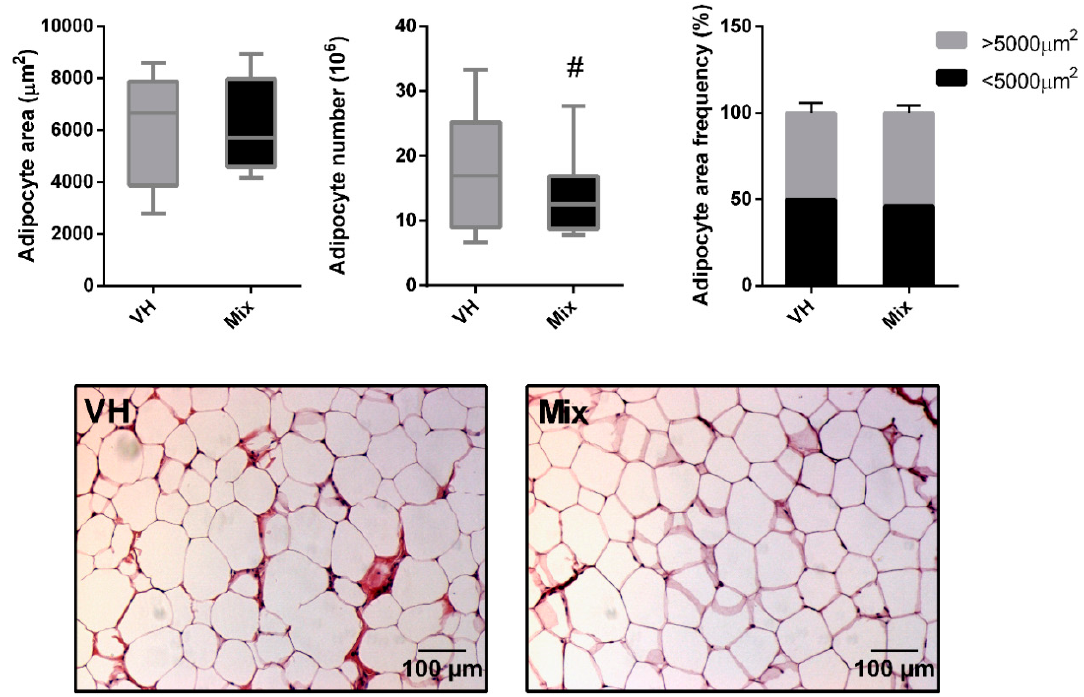
Figure 4. Adipocyte area, adipocyte number, and adipocyte area frequencies in IWAT of rats fed a CAF diet for 11 weeks and supplemented with the vehicle or a mix of ingredients containing GSPE, anthocyanins from bilberry and blackcurrant, CLA, and CFH during the last three weeks. Representative pictures of both CAF groups are shown. For frequencies, adipocytes were distributed in two groups depending on their areas ( < 5000 or > 5000 µ m 2 ). Box plots represent the median and Tukey whiskers ( n = 16), and statistical significance was analyzed via Student’s t -test ( # p < 0.1).